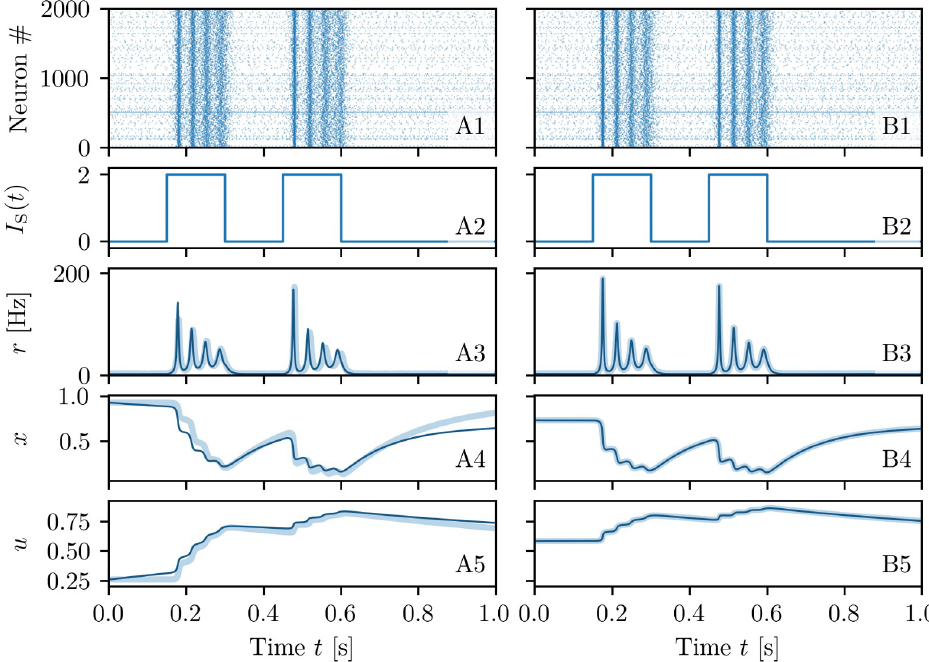
Fig 1. Comparison among neural mass and network models. The results of the neural mass model (solid line) are compared with the network simulations (shaded lines) for a single excitatory population with μ -STP (column A) and with m-STP (column B). The corresponding raster plots for a subset of 2000 neurons are reported in ( A1-B1 ), the profiles of the stimulation current I ( t ) in ( A2-B2 ), the instantaneous population firing rates r ( t ) in ( A3-B3 ), the S available synaptic resources x ( t ) in ( A4-B4 ), and the utilization factors u ( t ) in ( A5-B5 ). The variables of the neural mass model are initialized to values coinciding with those of the corresponding network simulations. Since the numerical experiments for the single excitatory population with μ -STP (column A) and with m-STP (column B) are independent, the initial values of the synaptic variables do not coincide, even though a similar dynamical evolution is observable in both cases. Simulation parameters are t e ¼ 15 ms, H = 0, Δ = 0.25, J = 15, I B = − 1 and network size m N = 200,